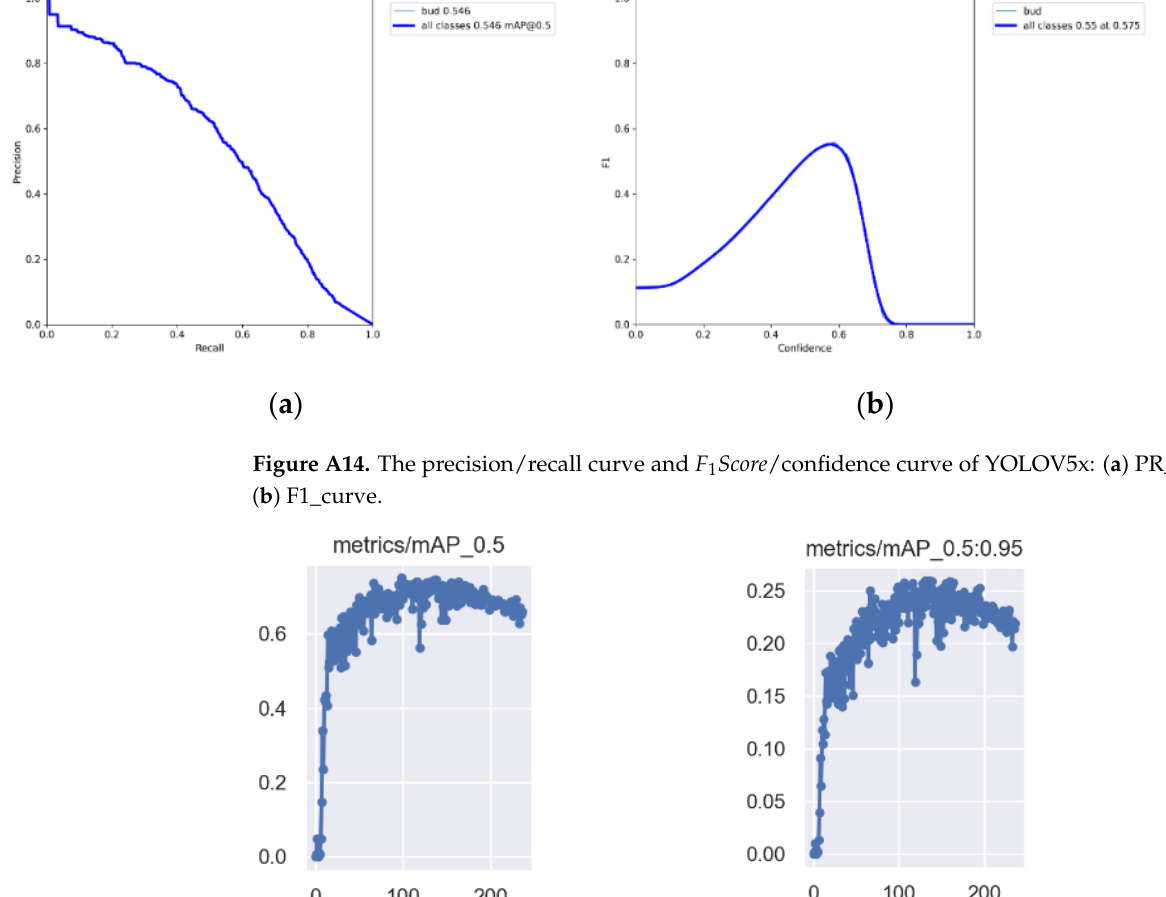
Figure A13. The changes of recall of YOLOV5x.